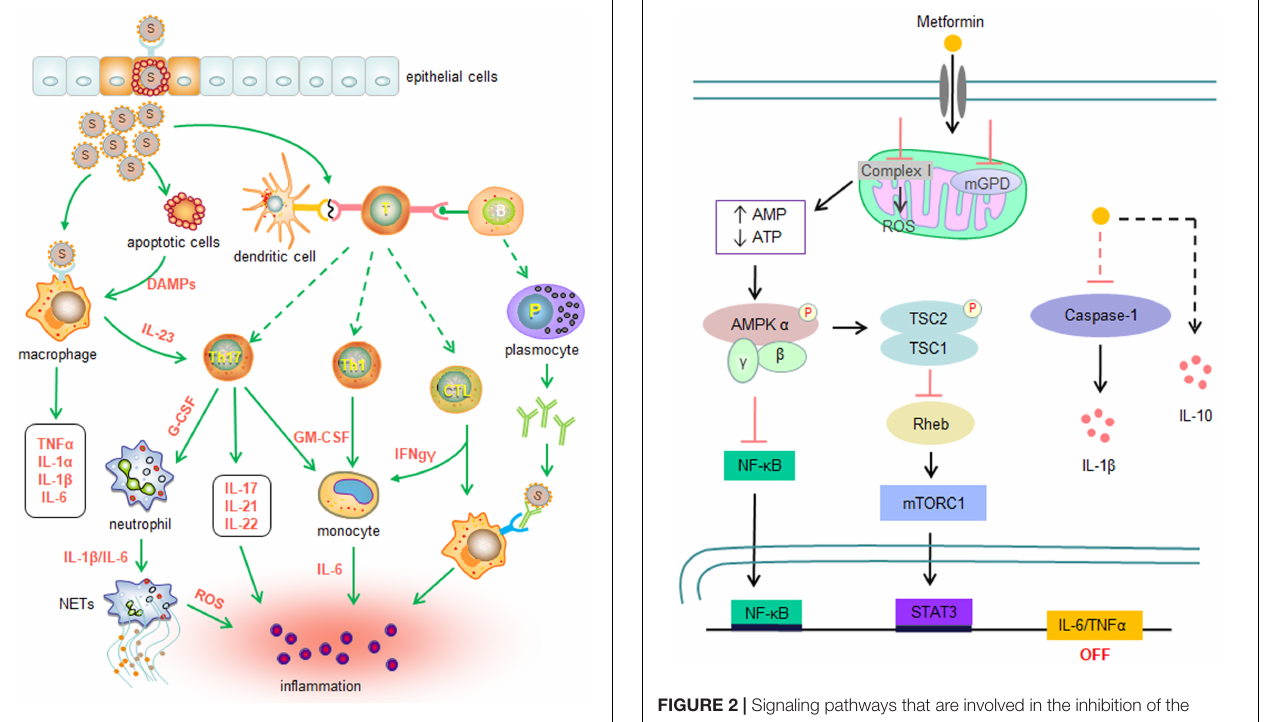
FIGURE 1 | Putative innate immune responses induced by SARS-CoV-2 infection. SARS-CoV-2 and DAMPs released from damaged cells activate macrophages and cause the production of proinflammatory cytokines, such as IL-1 α , IL-1 β , IL-6, and TNF α , in the early stage of infection. The adaptive immune responses subsequently lead to the secretion of proinflammatory cytokines and chemokines, which may promote further innate cell recruitment and activation. Furthermore, activated Th17 cells and Th1 cells may recruit neutrophils and monocytes through the release of G-CSF and GM-CSF, respectively. Activated CTLs may drive the differentiation of monocytes and macrophages by secreting IFN γ . Inflammatory chemokines and cytokines also recruit and activate neutrophils to produce ROS and NETs. Taken together, the cytokine storm induced by innate immune cells ultimately results in inflammation and injury.